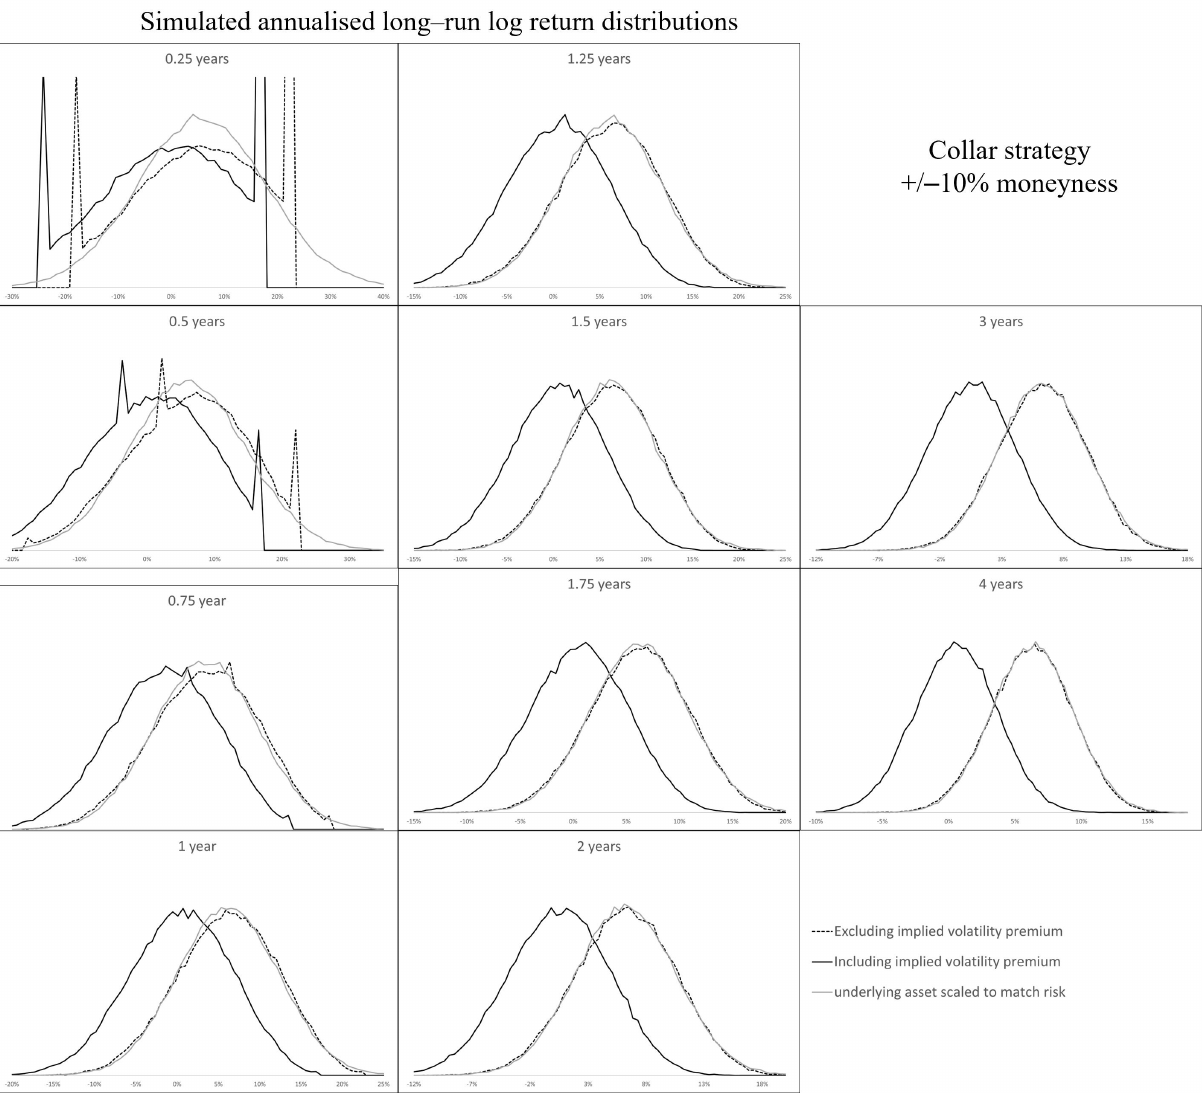
Figure 24. Simulations of the long-run returns of an underlying asset overlaid with a quarterly ± 10% moneyness symmetric collar strategy over investment horizons of 1 / 4 year, 1 / 2 year, 3 / 4 year, 1 year, 1 1 / 4 years, 1 1 / 2 years, 1 3 / 4 years, 2 years, 3 years, and 4 years. The dotted line assumes the implied volatility is equal to the underlying asset volatility. The solid line includes the implied volatility premium in the price of the options. The gray line shows the long-run returns of a portfolio consisting of the risk-free asset and the underlying asset weighted to have the same risk as the option